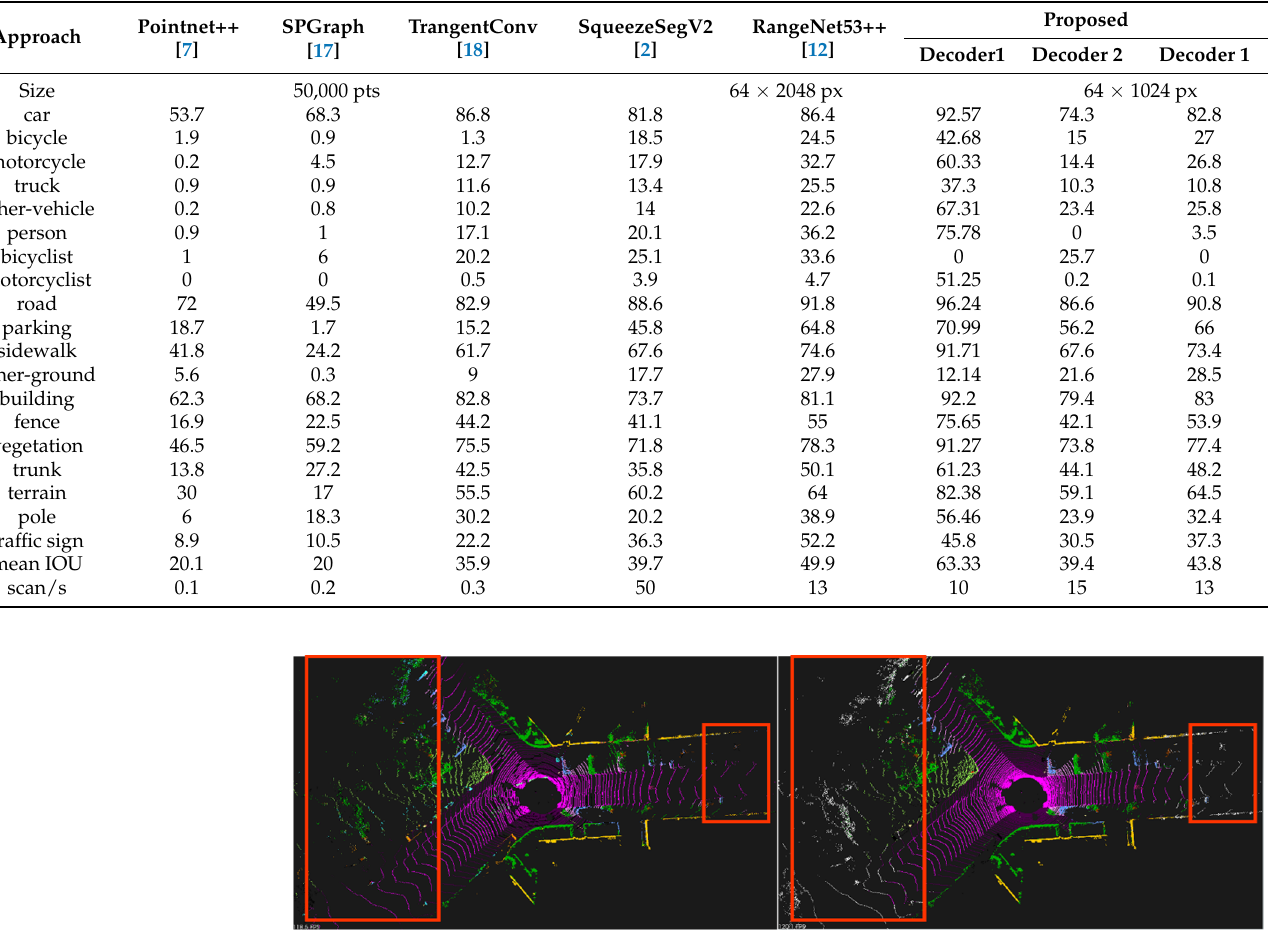
Table 4. IoU [%] on test set (Sequences 11 to 21).